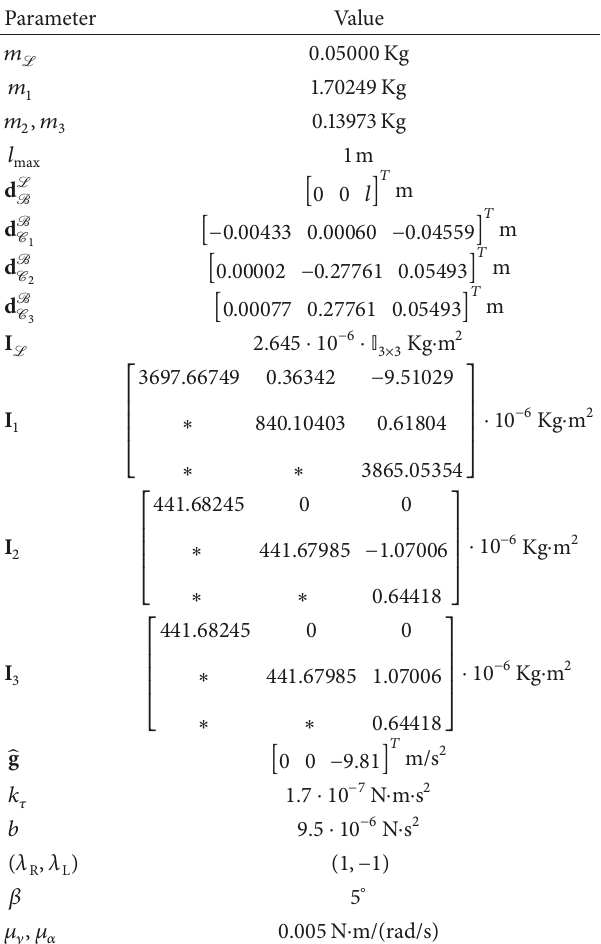
Table 1: Model parameters of the tilt-rotor UAV with suspended load.